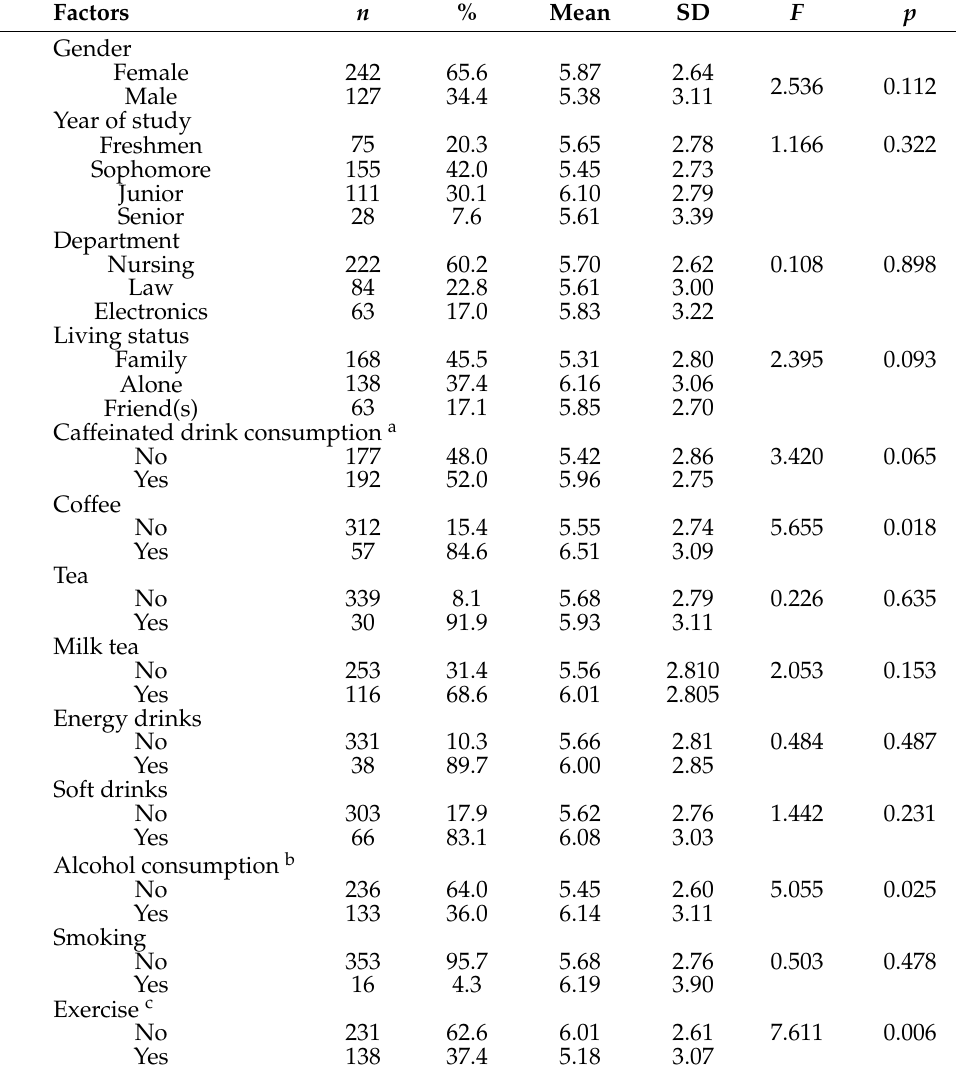
Table 1. ANOVA of demographic characteristics and lifestyle behaviors on sleep quality (PSQI-V Scores) (N =